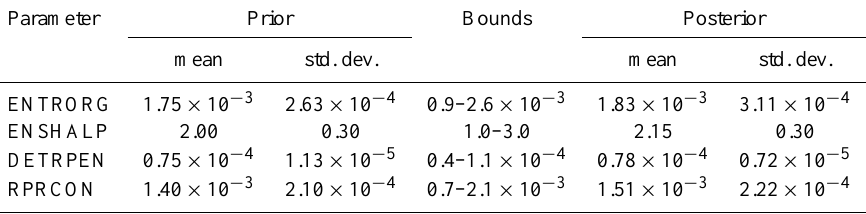
Table 2. IFS parameter values applied in the EPPES tests. Prior mean values correspond to the default model values. Prior standard deviation (the standard deviation of the proposal distribution of the first ensemble) and bounds (minimum and maximum allowed parameter values) are subjectively specified. Posterior mean and standard deviation are the EPPES estimates after 177 estimation steps with the specified cost